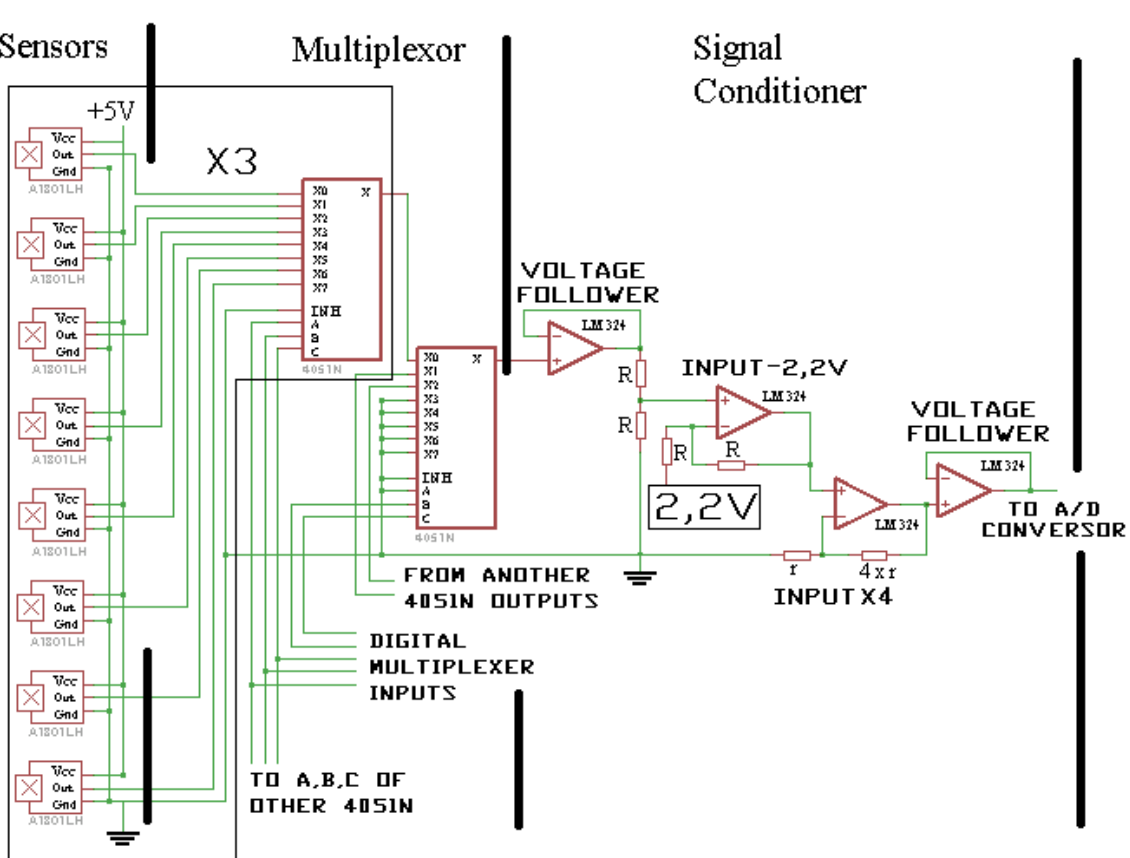
Figure 2. Electronic sketch of the array of sensors, multiplexing and conditioning of the